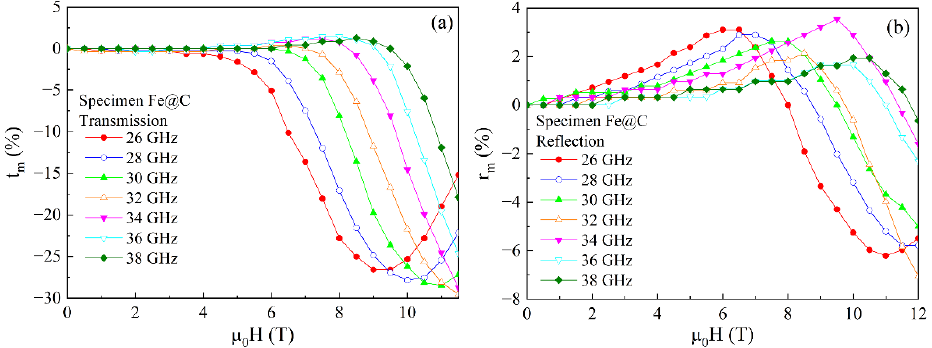
Figure 9. Magnetic field dependences of the transmission ( a ) and reflection ( b ) coefficients measured at several frequencies of the millimeter waveband for the sample of 2 mm thick with Fe@C particles.